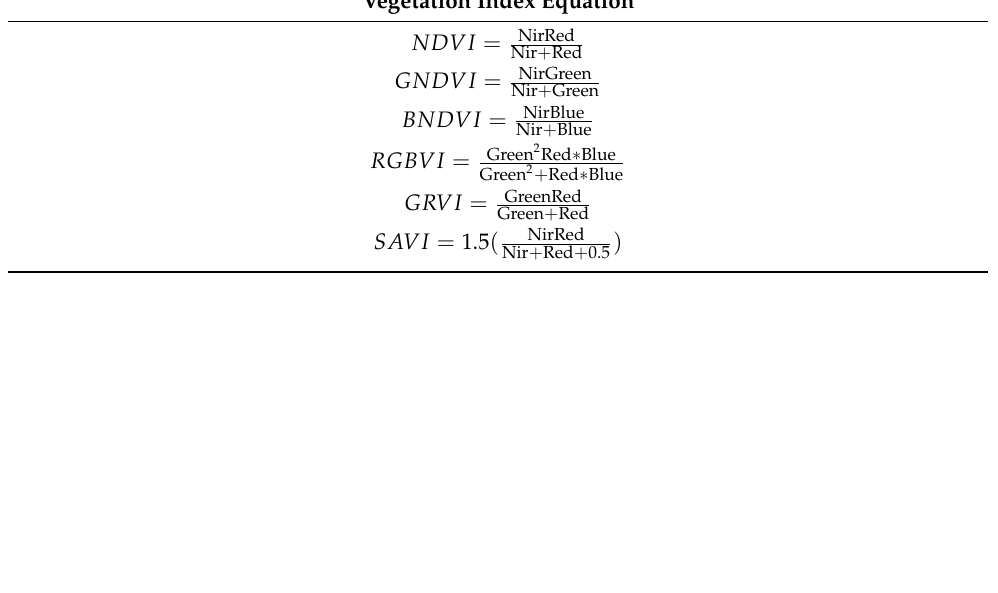
Table 3. Existing vegetation index equations. Vegetation Index